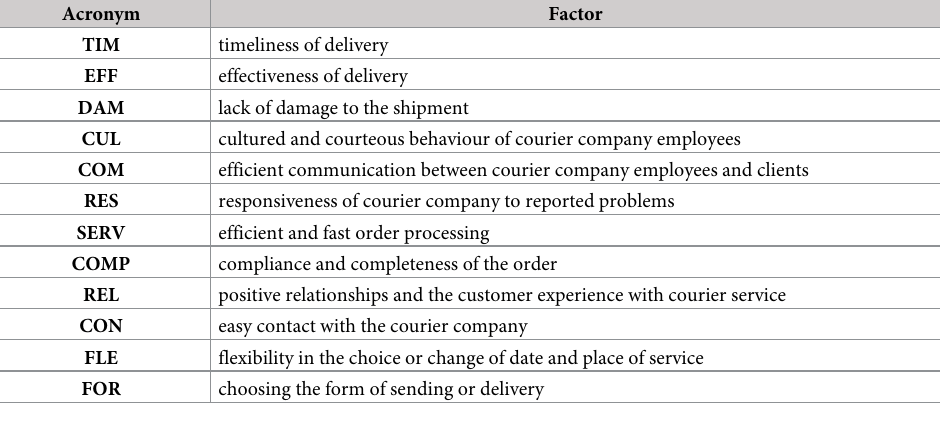
Table 2. List of key factors determining the courier service quality.